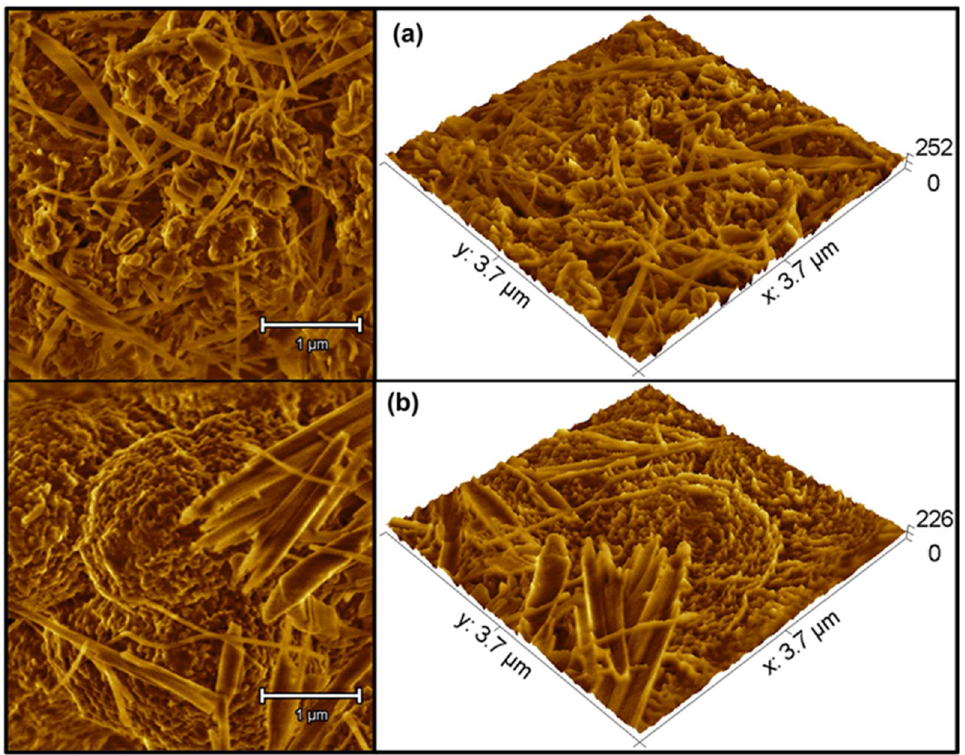
Figure 4. The 2D and 3D zoom reconstructions of SEM images (50,000×) for ( a ) PPA1 HT and ( b ) PPA16 Ht-HH . ( b ) PPA16 Ht-HH